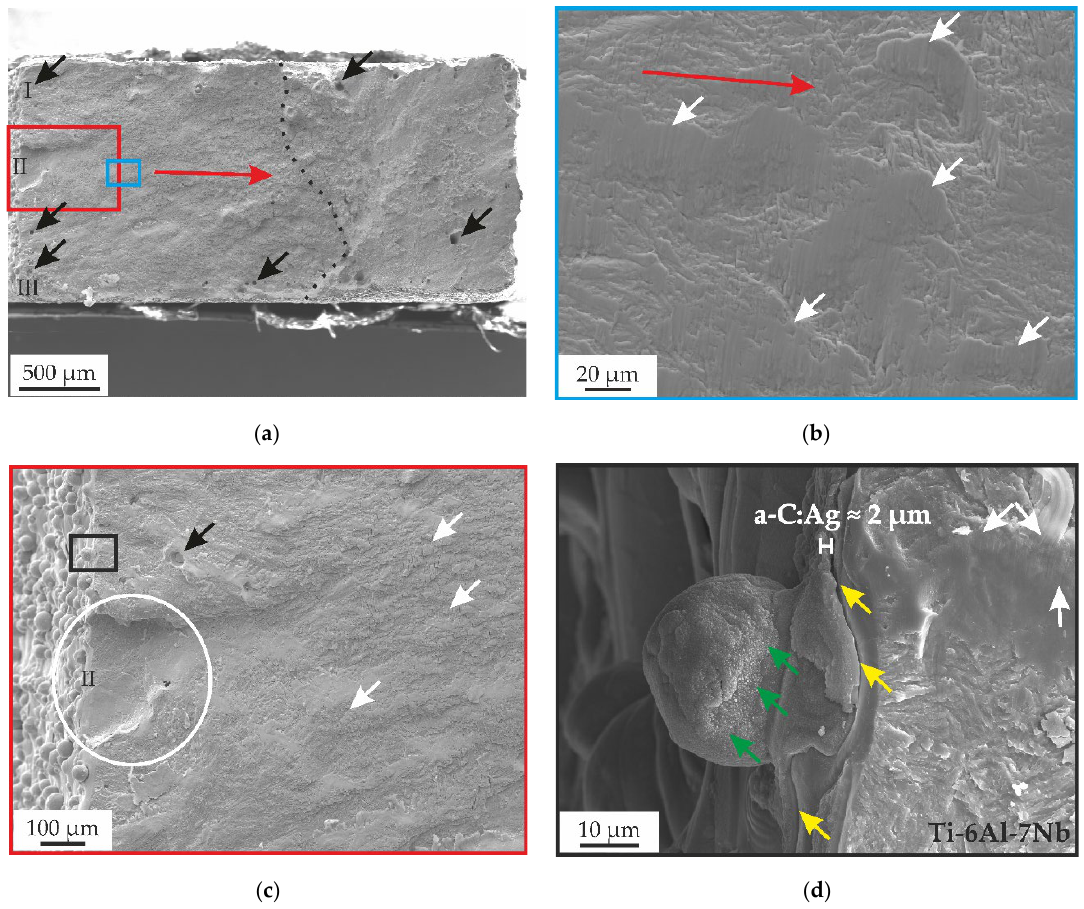
Figure 6. SEM images of the fracture surface of an a-C:Ag-coated specimen; ( a ) overview SE image of the fracture surface, dashed line separating fatigue (left) and forced fracture (right), Roman numerals indicating the possible crack nucleation sites, black arrows marking pores; ( b ) detailed view of the blue rectangle in ( a ), showing the fatigue characteristic striations (white arrows) and the crack propagation direction (red arrow); ( c ) overview of the fatigue fracture surface with fatigue striations (white arrows) and LPBF characteristic defects such as pores (black arrow); ( d ) detailed in-lens image of the black square in ( c ) showing the a-C:Ag coating on the surface (yellow arrows) and the fatigue fracture surface (right area) with fatigue striations (white arrows), a coated powder particle on the surface of the specimen with Ag particles (green arrows).